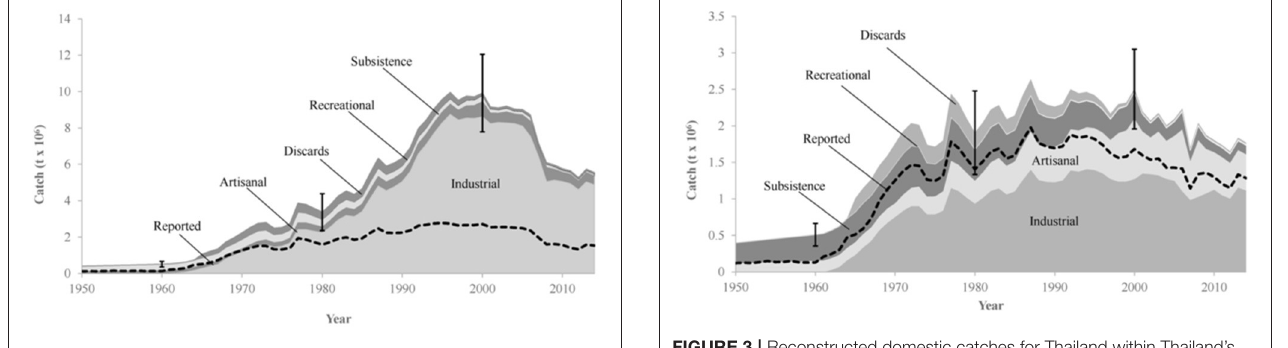
FIGURE 3 | Reconstructed domestic catches for Thailand within Thailand’s EEZ only for 1950–2014, showing contribution of different sectors. Reported landings data are overlaid as a dashed line.